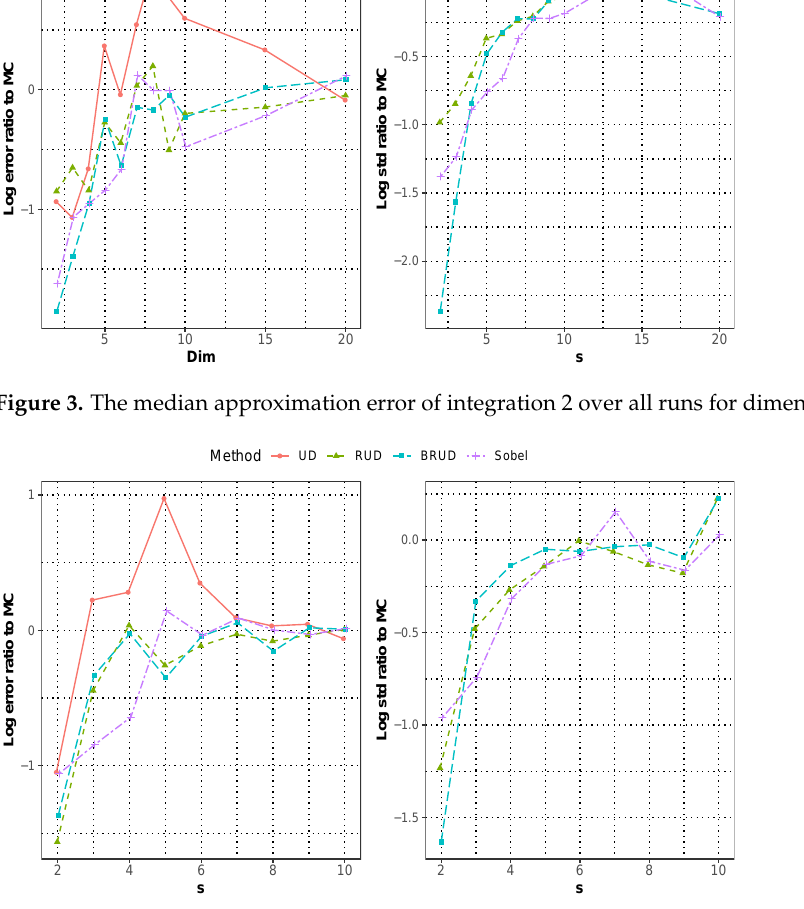
Figure 4. The median approximation error of integration 3 over all runs for dimension s ≤